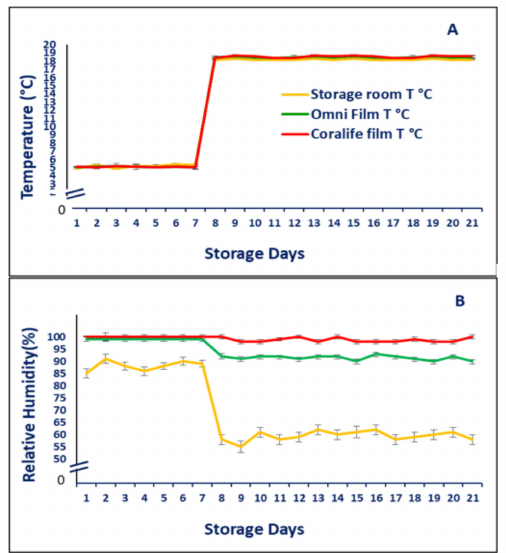
Figure 2. Average temperature ( A ) or humidity ( B ) of the storage room or the packages headspace. For each day, means followed by unlike letters are significantly different at p ≤ 0.05. Means separation was accomplished using Duncan’s multiple range test. Vertical bars are the standard deviations of three replications (n =